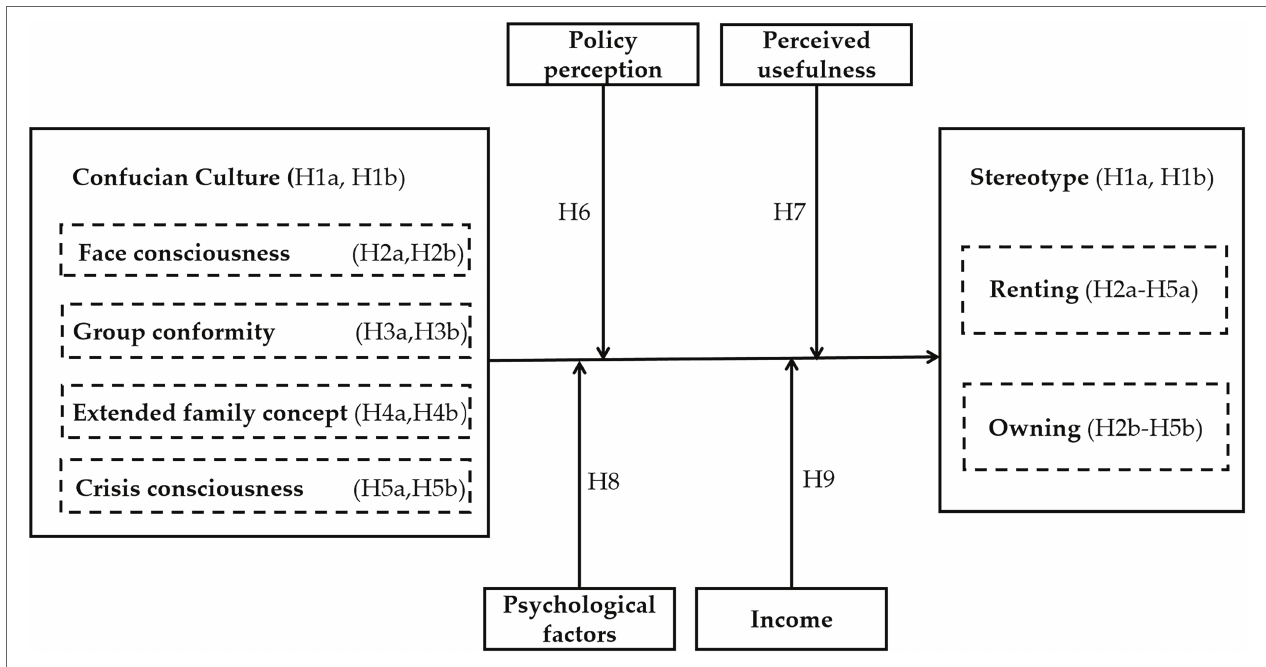
FIGURE 1 | Conceptual framework.